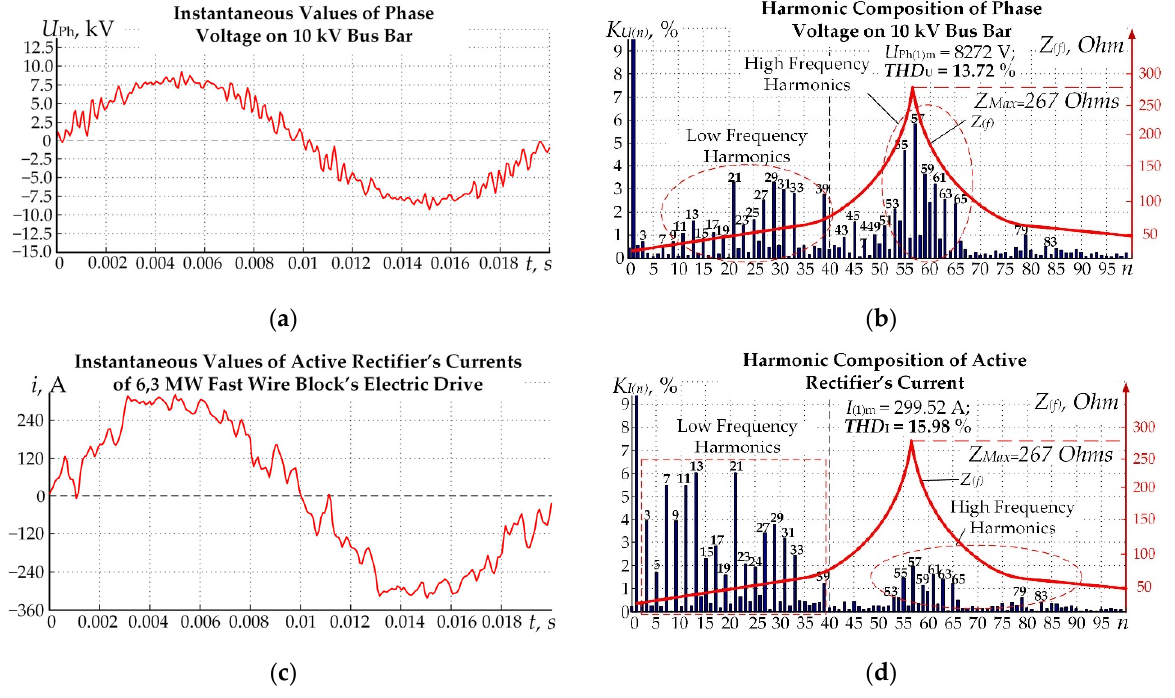
Figure 17. The instant phase voltage values in the 10 kV buses ( a ) and their harmonic spectrum and grid frequency response ( b ); instant 6.3 MW current values for a Fast Wire Block’s Electric Drive ( c ) and their harmonic spectrum ( d ).